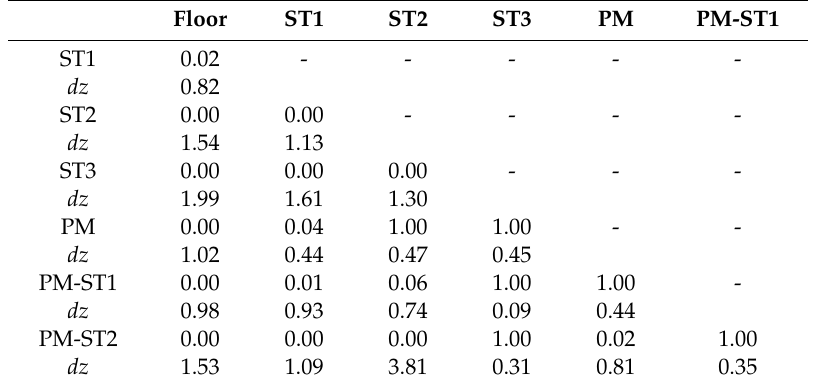
Table 2. P -values and e ff ect sizes ( dz ) for post hoc comparisons between balance conditions.